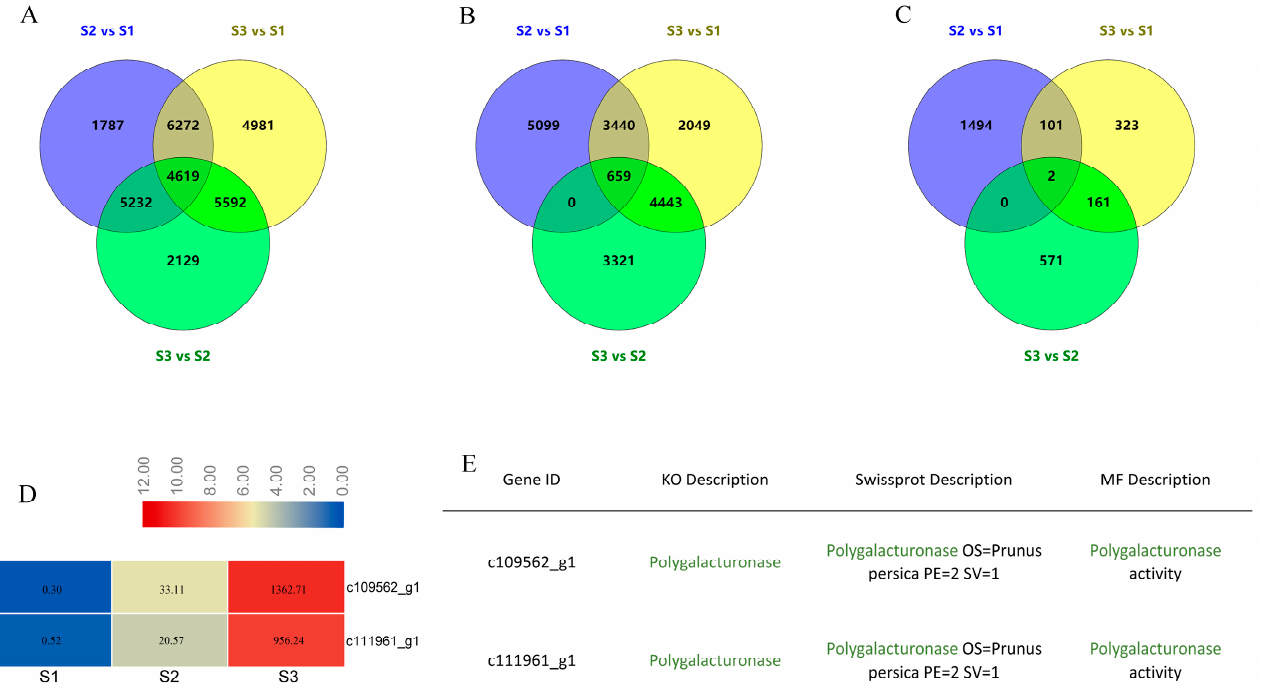
Figure 2. The Venn diagrams of differentially expressed genes (DEGs) and the expression levels of transcripts. ( A ) Venn diagrams of all DEGs among three comparisons including S2 vs. S1, S3 vs. S1, and S3 vs. S2. ( B ) Venn diagrams of upregulated DEGs among three comparisons including S2 vs. S1, S3 vs. S1, and S3 vs. S2. ( C ) Venn diagrams of upregulated DEGs with a 5 ‐ fold change among three comparisons including S2 vs. S1, S3 vs. S1, and S3 vs. S2. ( D ) Expression levels of two key transcripts including c109562_g1 and c111961_g1. ( E ) Annotations of c109562_g1 and c111961_g1. The green font indicates c109562_g1 and c111961_g1 were both annotated as polygalacturonase in three known online databases including KO, Swissprot, and MF.